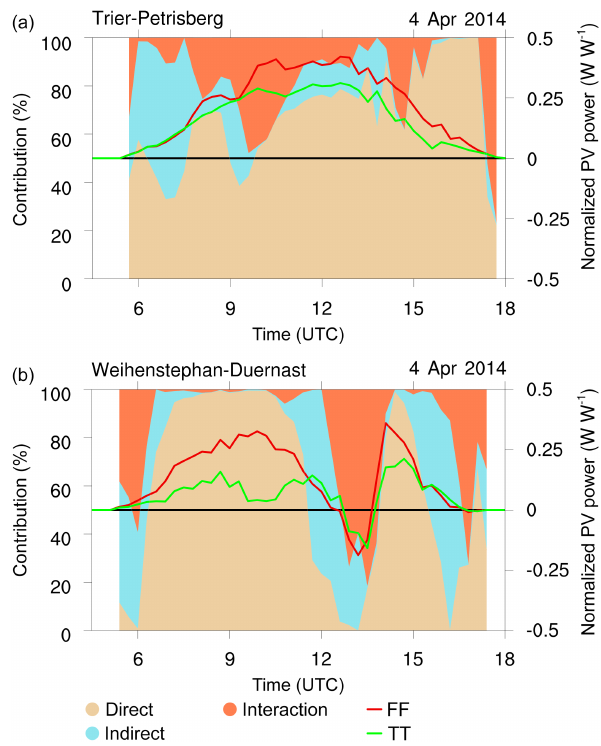
Figure 12. Temporal evolution of the difference in normalized PV power between TT and measurements (green line, right ordinate) and the corresponding difference between FF and measurements (red line, right ordinate) on 4 April 2014 at Mannheim (a) and Meiningen (b) . Contours: percentaged contribution of direct ra- diative, indirect radiative and synergistic interaction effects to the change between TT and FF based on the FM calculation (left ordi- nate).